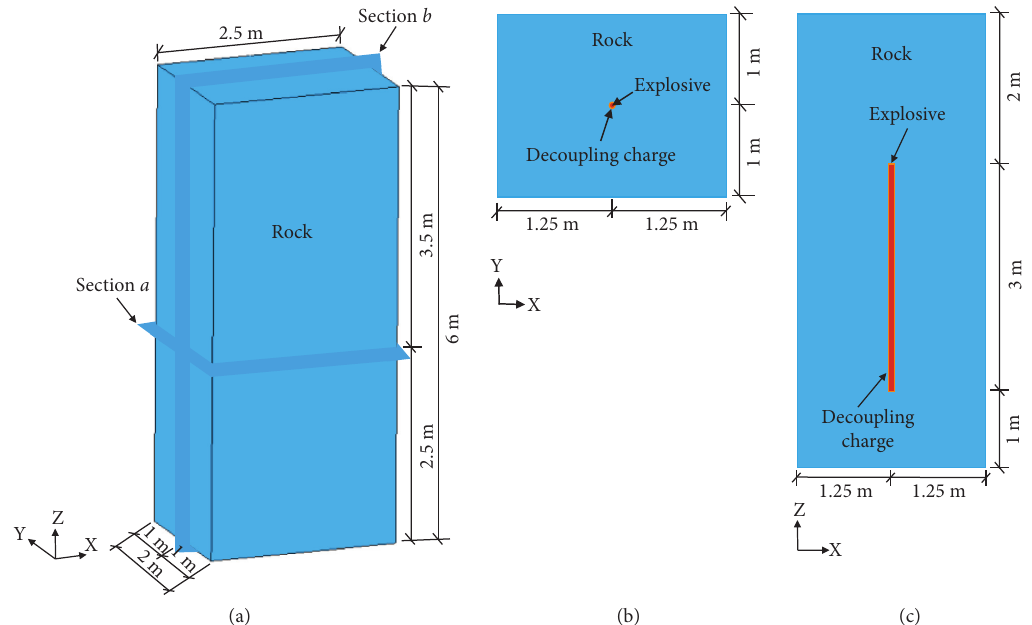
Figure 1: Single-hole analysis model considering near zone damage. (a) The entire model. (b) Section (a). (c) Section (b).